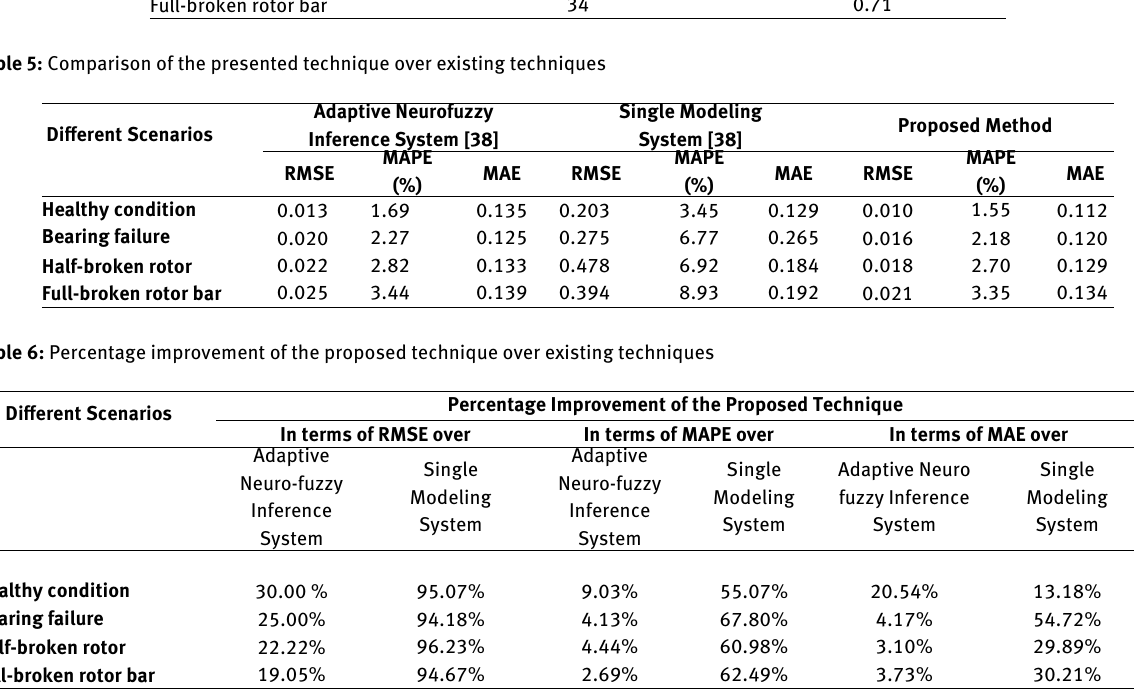
Table 5: Comparison of the presented technique over existing techniques